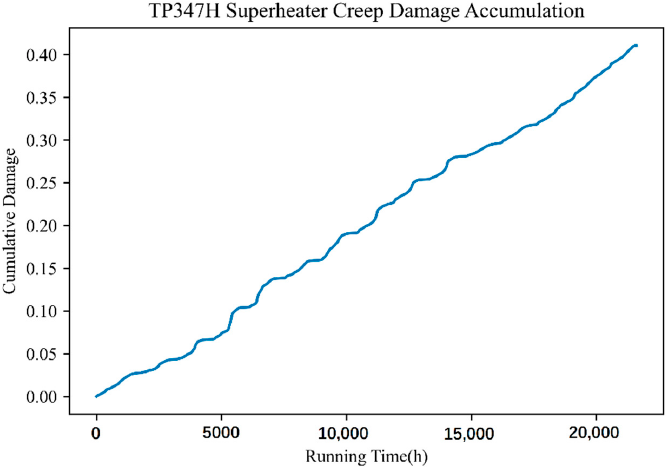
Figure 7. Relationship of service time and creep damage amount of high-temperature superheater TP347H material. TP347H